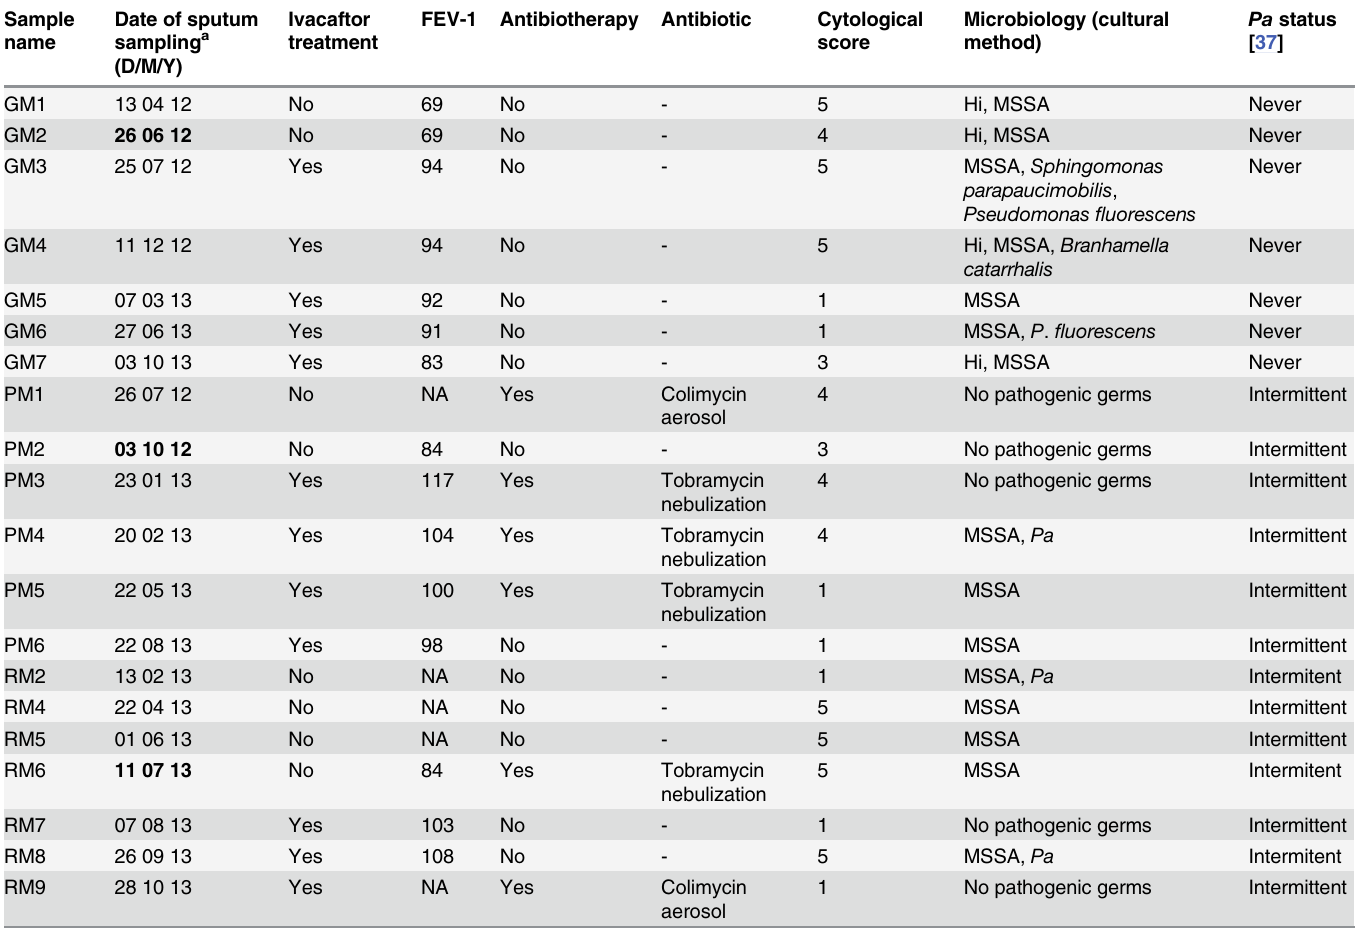
Table 1. Patient characteristics associated with each sputum